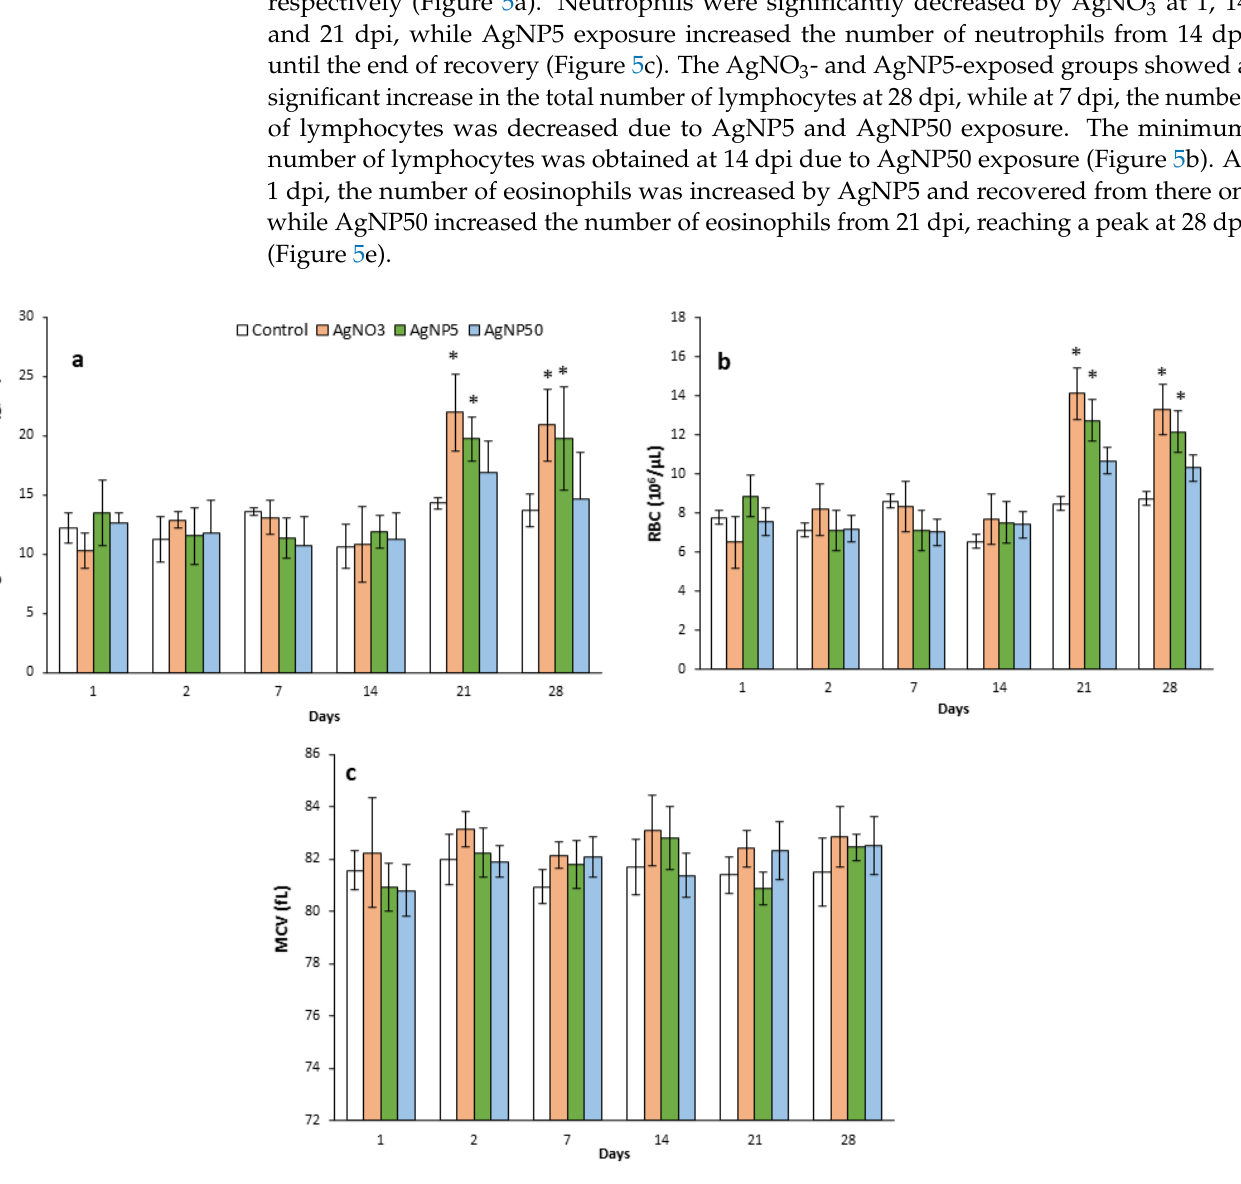
Figure 4. Differential mice blood cell counts for hemoglobin concentration ( a ), RBC ( b ) and MCV ( c ) over a 28-day recovery time after repeated intratracheal instillations of saline (control), AgNO 3 , AgNP5 and AgNP50. * means significant differences between the control and treatments (one-way ANOVA; Dunn’s test p < 0.05) ( n = 4).